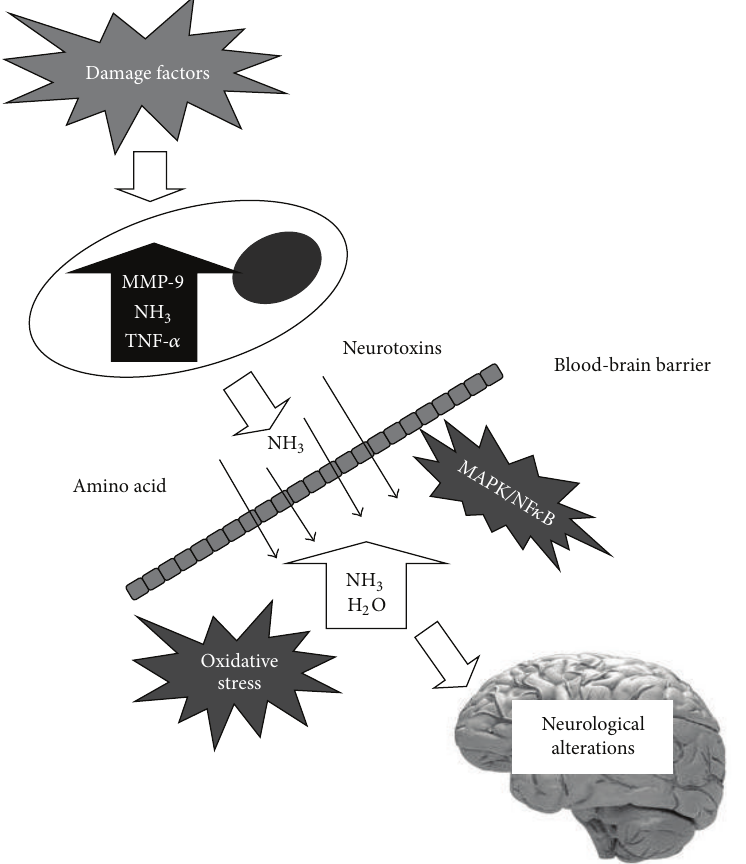
Figure 3: The pathogenesis of brain edema in ALF involves the action of neurotoxins such as ammonia and TNF- 𝛼 and MMP-9, as well as various phenomena that include alterations in neurotransmission, blood-brain barrier permeability, and energy